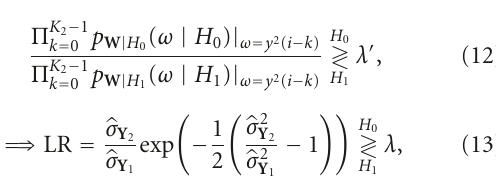
= σ 2 N 1 ). ξ 1 denotes the a priori 2